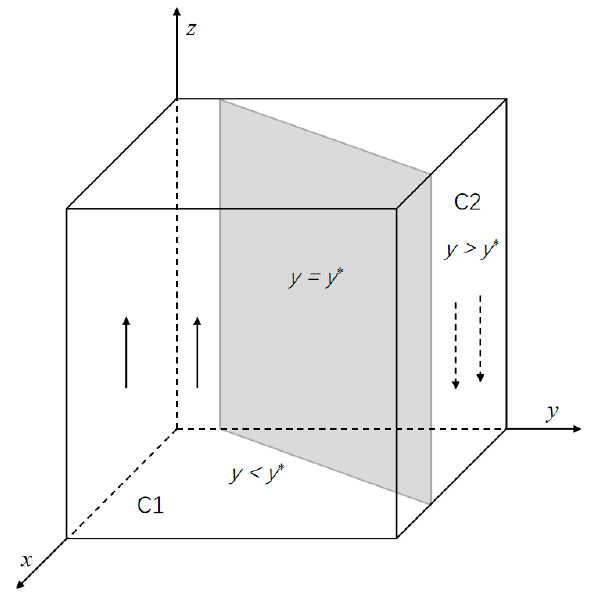
Figure 4. Phase diagram for the strategy evolution of the government.